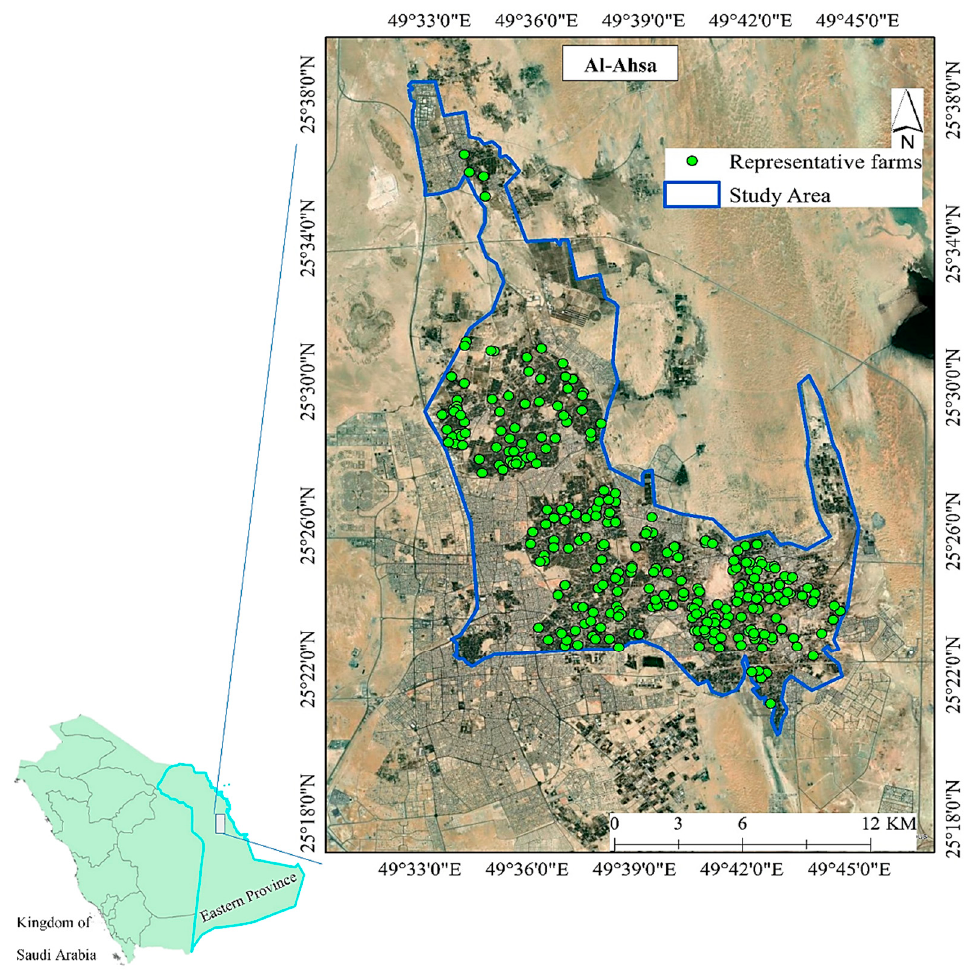
Figure 1. Study area map, where Al-Ahsa oasis is delineated in the blue and the distribution of the representative farms is marked in the green.